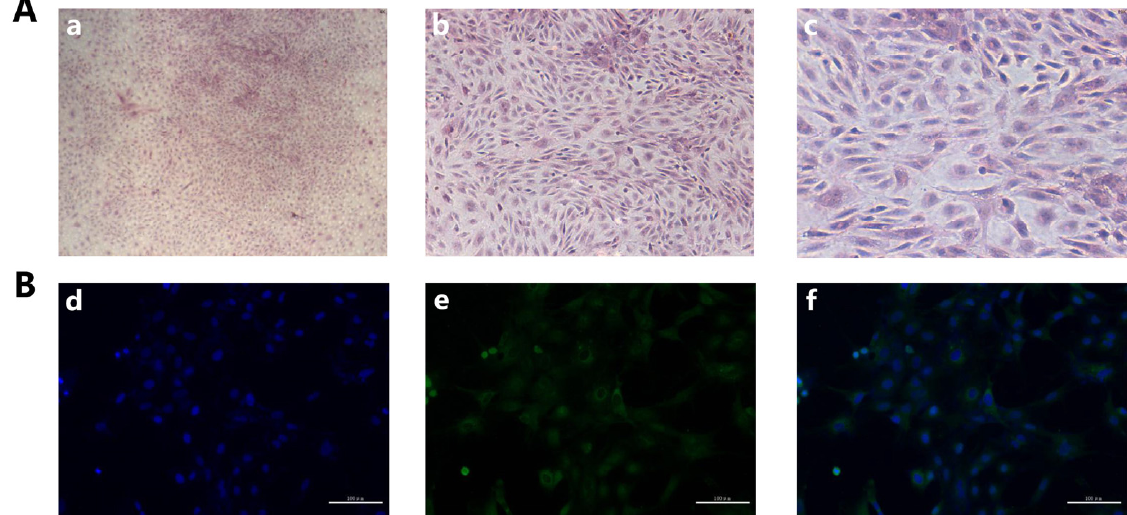
Figure 1. Isolation and identification of rabbit GCS: ( A ): GCS were stained with Hematoxylin and eosin (H&E) staining, ( a – c ): Original magnification, 40 × , 100 × , 200 × . ( B ): The identification of rabbit GCS was measured by immunofluorescence staining with fluorescein isothiocyanate (FITC)-goat anti-rabbit IgG. ( d ): Cell nucleus were stained by DAPI (blue), ( e ): FSHR were stained with fluorescein isothiocyanate (FITC)-goat anti-rabbit IgG (green), ( f ): Merge of ( d ) and ( e ). (Scale bar = 100 µ